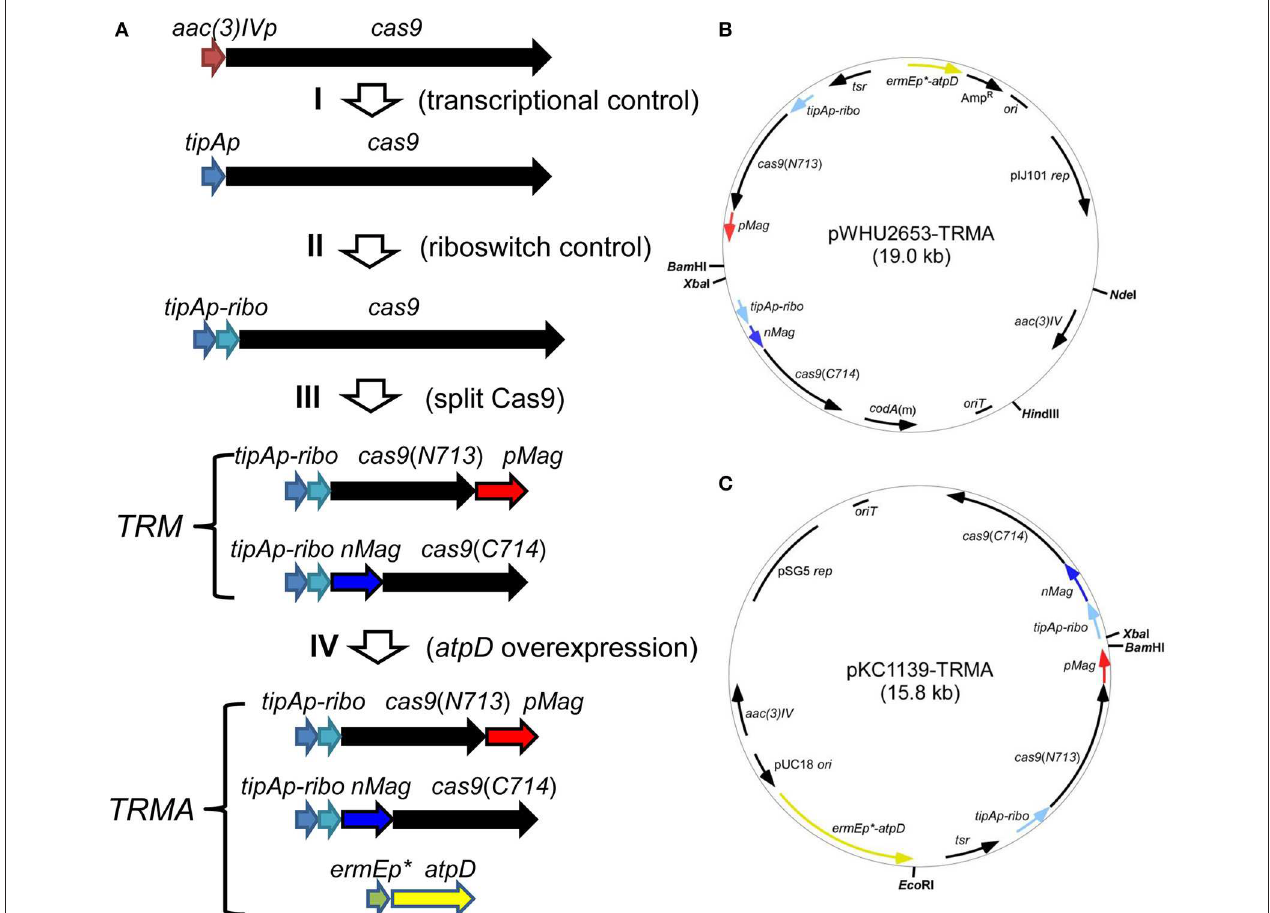
FIGURE 1 | Engineered controls of Cas9 activities and ATP supply for genome editing. (A) Strategy for the stepwise controls of Cas9 under the expression of tipAp , riboswitch and blue light for the pleiotropic controls at transcriptional (I), translational (II), and protein (III) levels. The ATP synthase gene atpD from S. coelicolor was additionally overexpressed under ermEp * (IV). (B,C) Two vectors containing genetic cassettes based on pIJ101 ori (from pWHU2653) and pSG5 ori (pKC1139) were shown as pWHU2653-TRMA (B) and pKC1139-TRMA (C) , respectively. All the genetic cassettes were labeled as in (A) and multiple-cloning sites are shown in